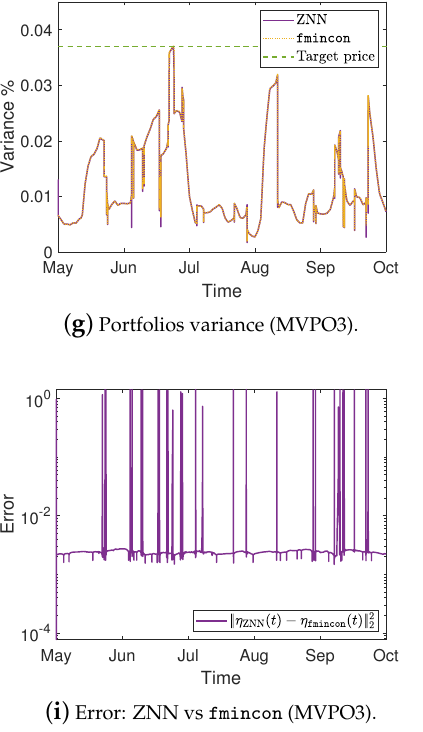
Figure 4. Portfolios variance %, expected return, and the error between ZNN and MATLAB’s solvers in case